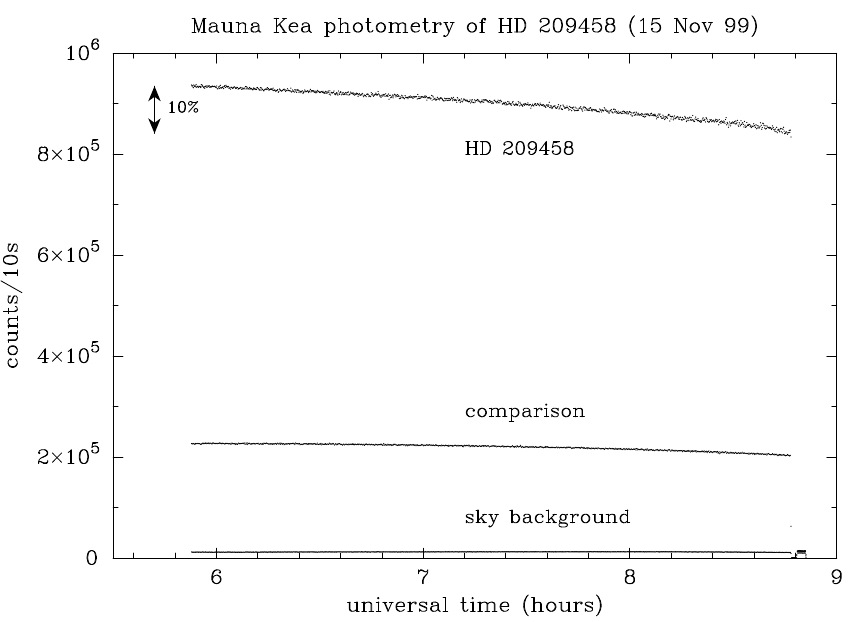
Fig. 1. The raw data for the high-speed photometry transit observations made on 15 November 1999.